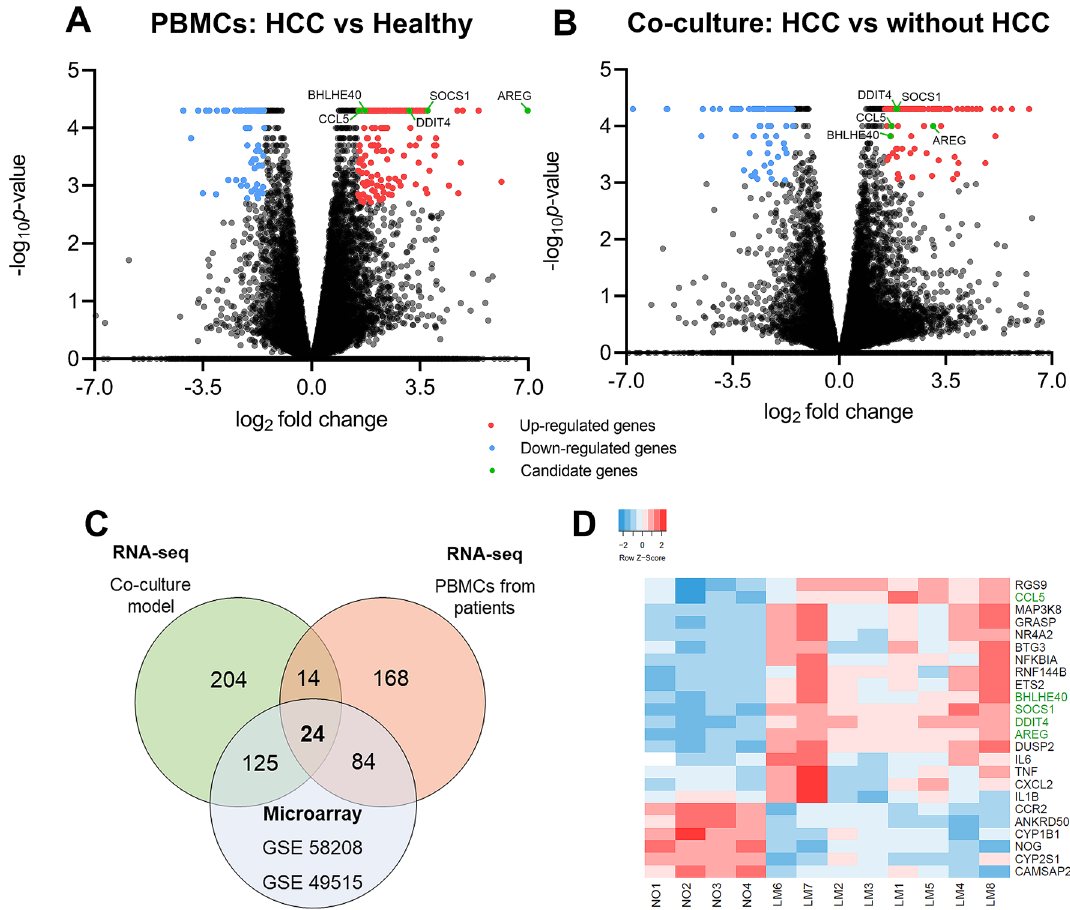
Figure 1. Transcriptome profiling of cancer-induce genes and integration transcription profiles of PBMCs. ( A ) volcano plot presents differentially expressed genes in PBMCs compared with healthy controls. ( B ) Volcano plot presents differentially expressed genes in PBMCs of co-culture compared with control. Volcano plot shows − log 10 P -values on the y-axis and fold change expressed as log 2 on the x-axis. Red scatter dots represent up-regulated genes with P ≤ 0.05 and log 2 fold change ≥ 1.5. Blue scatter dots represent down with P ≤ 0.05 and log2fold change ≤ -1.5. Green scatter dots represent a candidate of cancer-induced genes for validation in PBMCs. ( C ) Venn diagram represents intersect genes between 3 transcription profiles of PBMCs including PBMCs from patients with HCC, PBMCs from co-culture model and published microarray data. ( D ) Heatmap of cancer-induced genes expression in PBMCs of patients with HCC. Candidate of cancer-induced genes for validation are labels in